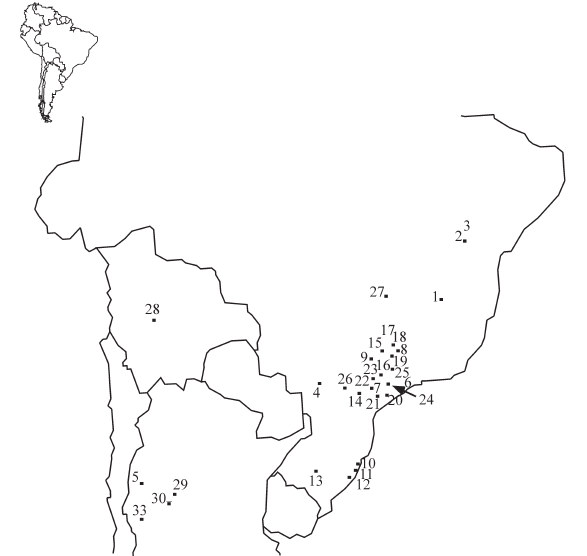
Figure1 -Thegeographicallocalitiessampledinthepresentstudy.Local- ity numbers are from Table